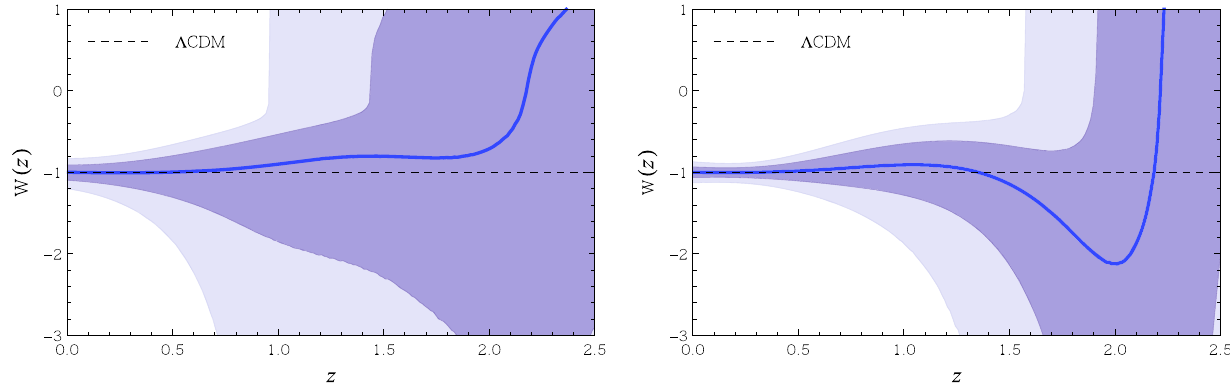
Fig. 5 The EoS w( z ) vs z with 1 σ and 2 σ CL regions, reconstructed from SN+BAO+CC data (left panel) and SN+BAO+CC+H0LiCOW data (right panel)